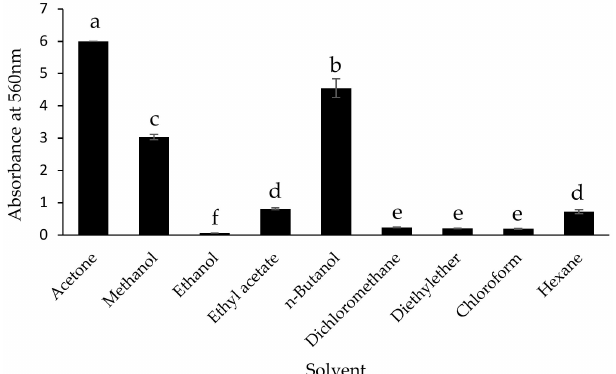
Figure 1. The effect of the indicated solvents on the absorbance of the reagent blank at 560 nm for the vanillin-sulphuric acid method. The values are the means of three replicates for each reaction. Columns not sharing the same superscript letter are significantly different at p < 0.05.